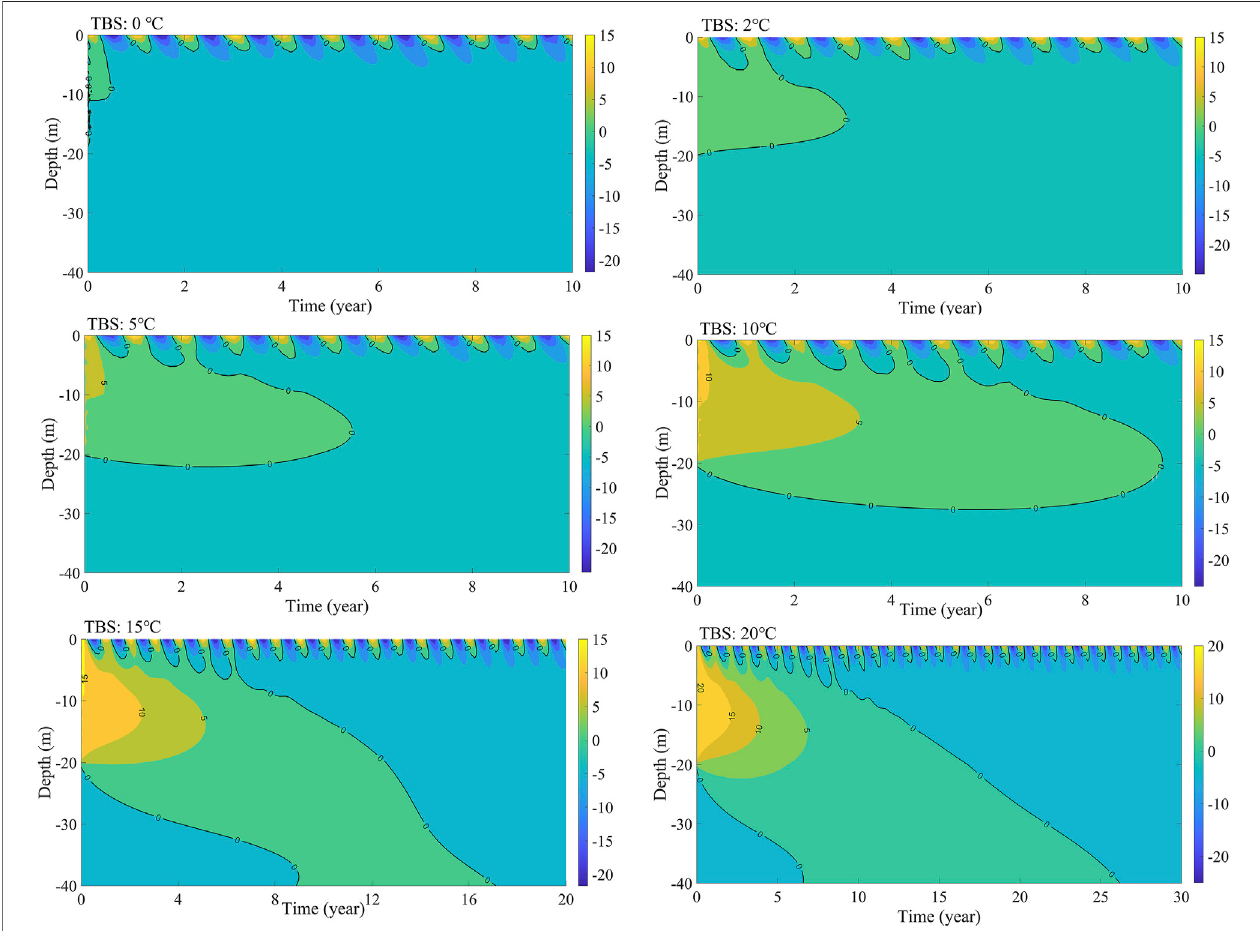
FIGURE 6| Variations in centerline temperature of the back fi lled area under different temperaturesof the back fi llingsoil (TBS) scenarios (0, 2, 5, 10, 15, and 20 ° C).